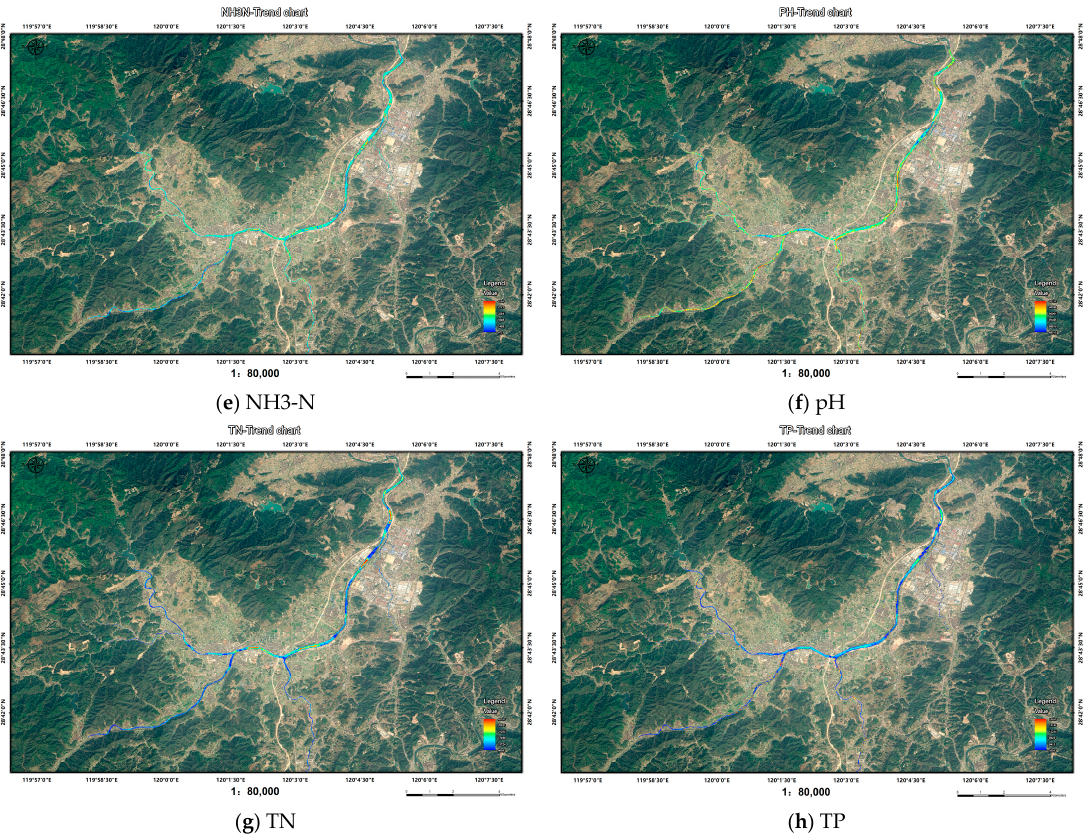
Figure 12. Cumulative concentration of water quality with 12 months from November 2020 to September 2022 in odd month. ( a – h ) represent BOD, COD, COD Mn , DO, NH3-N, pH, TN, and TP, respectively.